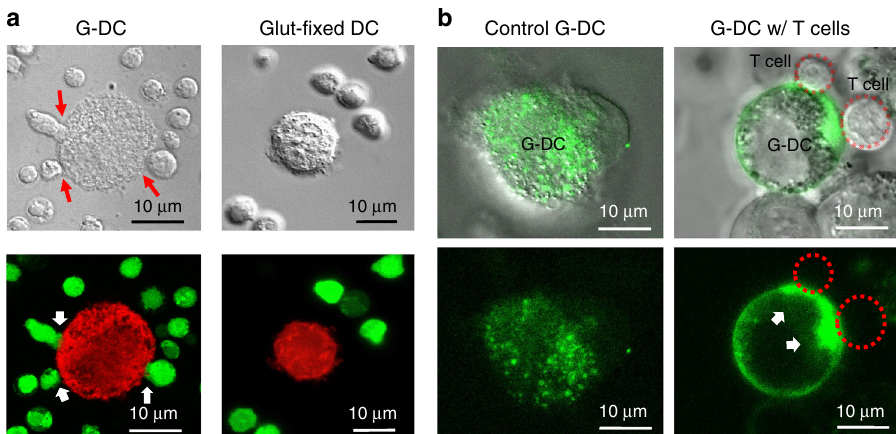
Fig. 6 Examination of G-DC/T-cell interaction and CD80 clustering. a Incubation of CSFE-labeled CD8 + T cells (green) derived from OT-I transgenic mice and SIINFEKL-pulsed G-DCs (red) showed dynamic interaction between the T cells and G-DCs under bright- fi eld and confocal fl uorescence microscopy. Red and white arrows indicate cell-cell conjugates. Scale bars = 10 μ m. b Incubation of CD80-GFP-expressing, SIINFEKL-pulsed G-DCs (green) and OT-I CD8 + T cells (red dashed-line circles) showed formation of CD80 clusters at the G-DC/T-cell junctions. White arrows indicate sites of CD80 clusters. Scale bars = 10 μ